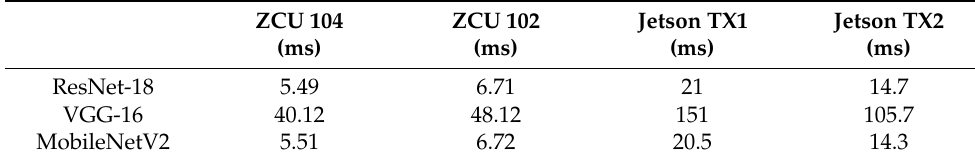
Table 2. Speed evaluation on FPGA.